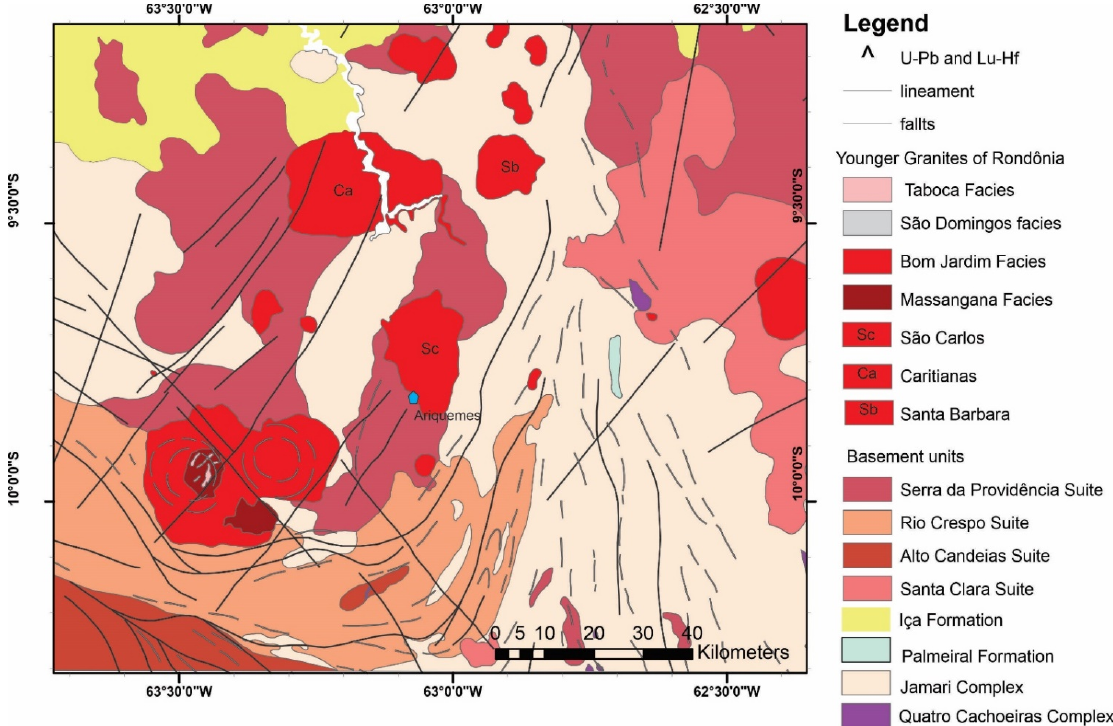
Figure 3. Schematic map with the location of all the massifs that comprise the Santa Clara Intrusive Suite; modified from [41]. Details of the Rondônia Tin Province highlighting only the intrusive suites